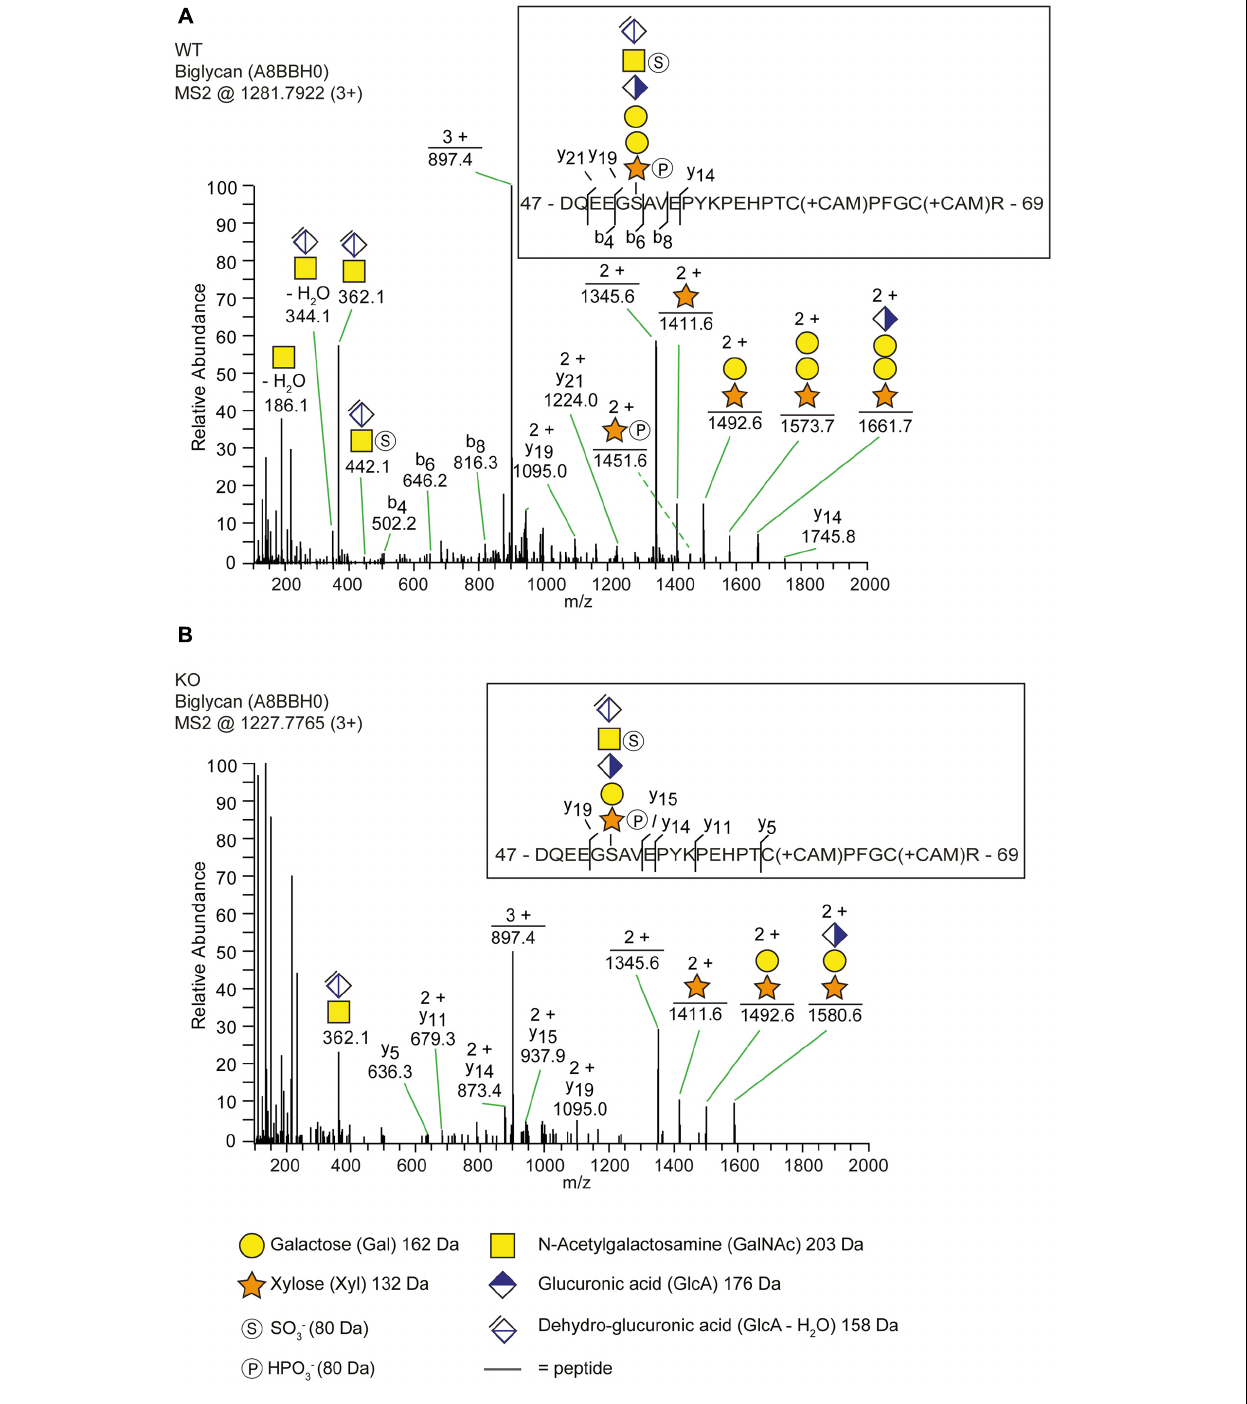
Frontiers in Cell and Developmental Biology | www.frontiersin.org